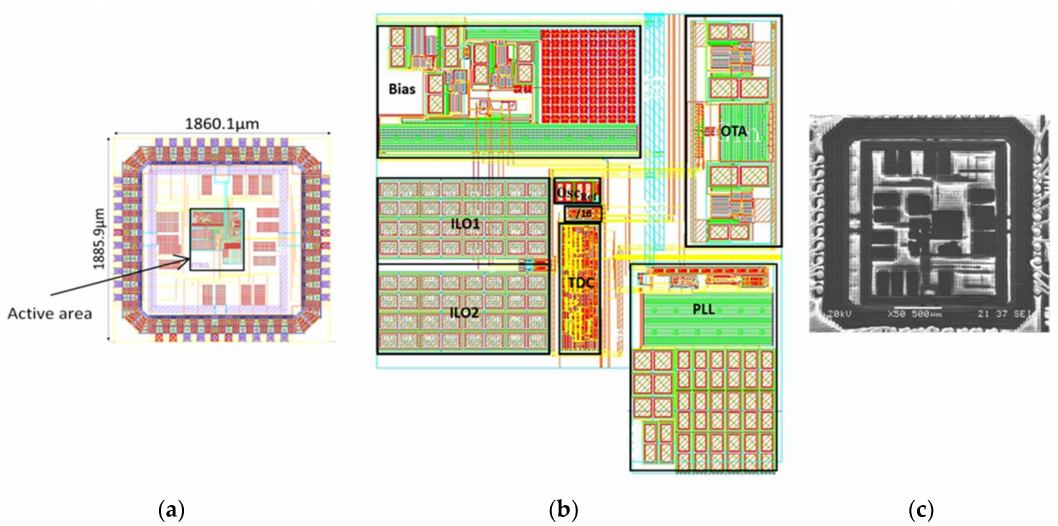
Figure 16. Sensor interface layout ( a ) Layout with the I/O rings; ( b ) Active area layout; ( c ) microphotography.